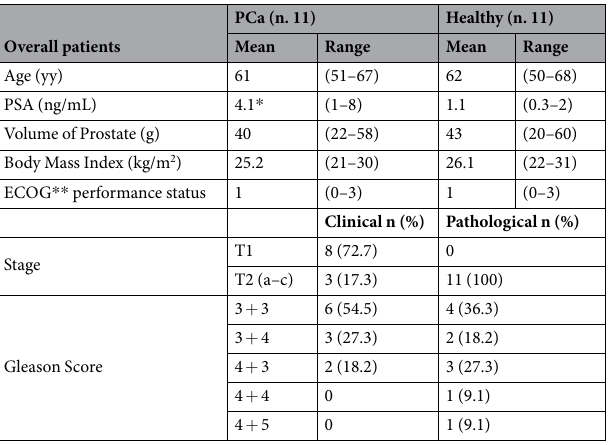
Table 1. Patients’ clinical parameters. * PSA value at diagnosis. ** ECOG (Eastern Cooperative Oncology